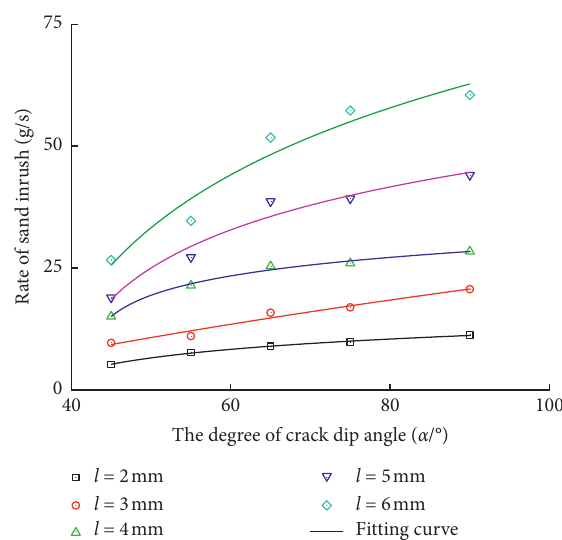
Figure 9: The curve of the relationship between the angle of fracture and the velocity of sand